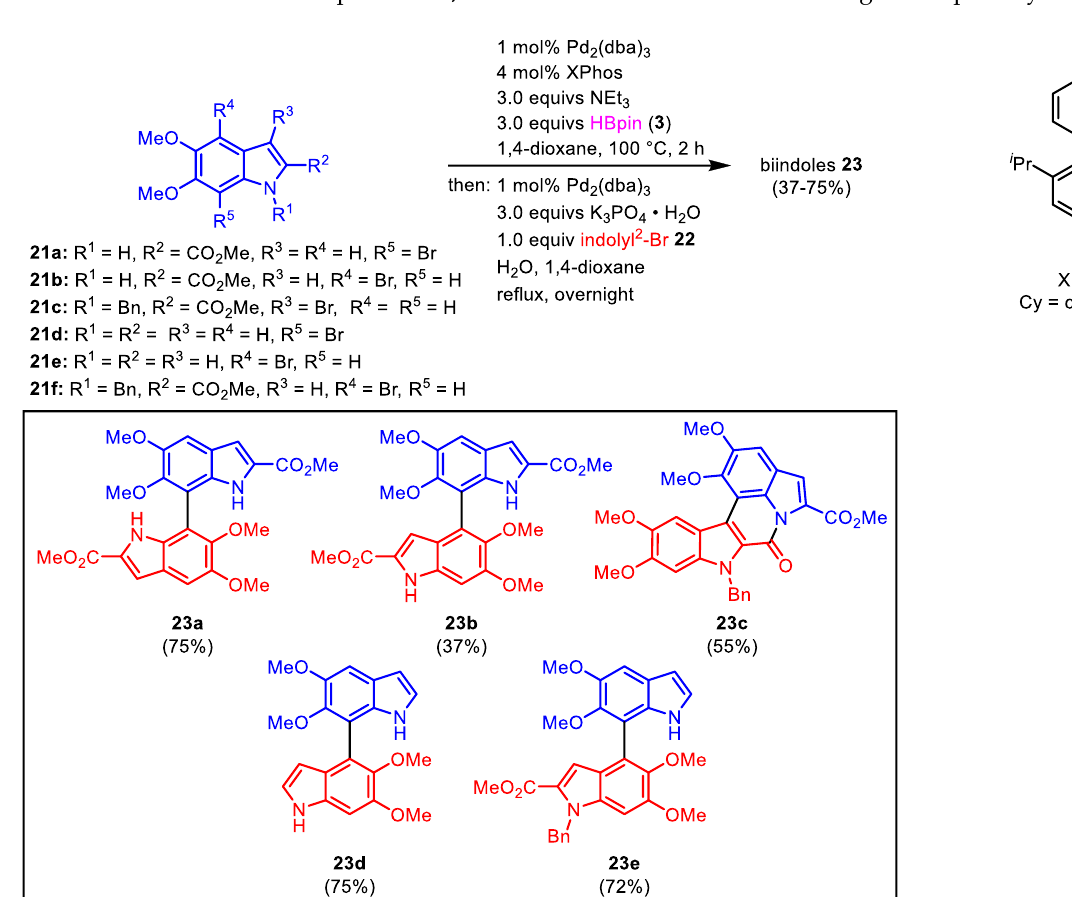
Figure 14. Chai’s and Huleatt’s one -pot MBSC synthesis of biindoles 23